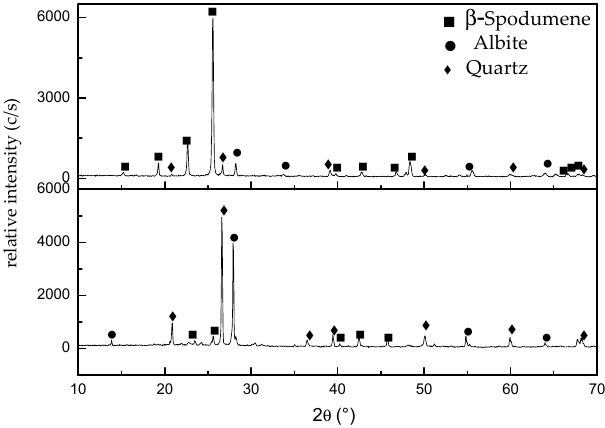
Figure 6. XRD of the leaching residues ( X : 0.2; time: 1 min; and temperature: 308 K).